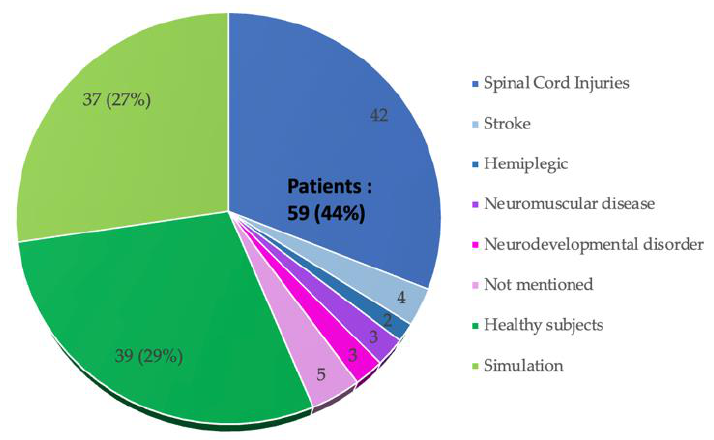
Figure 8. Last level of the experimental method.